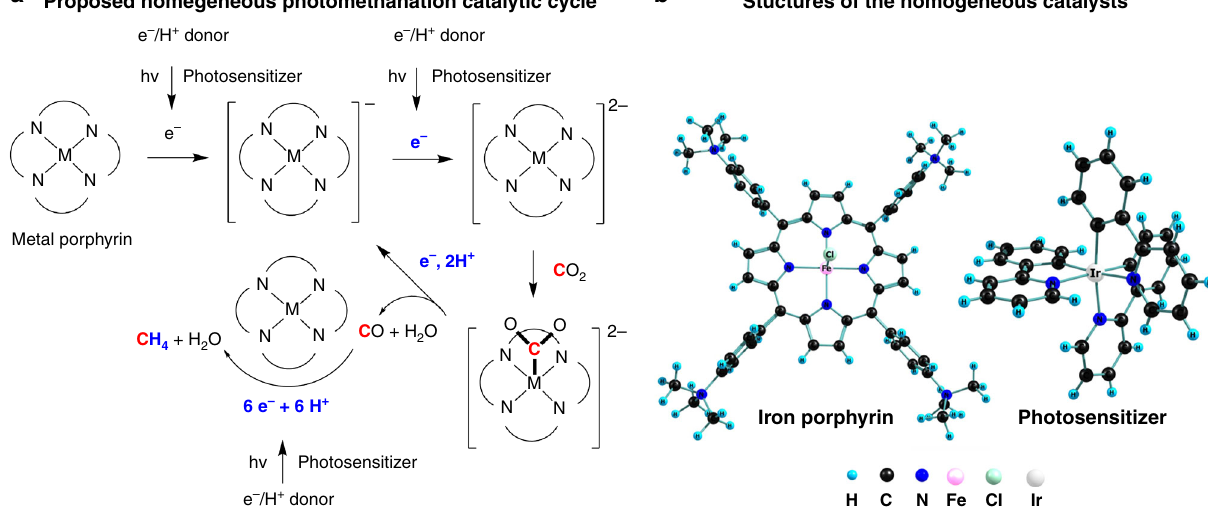
Fig. 7 a A proposed sequence of steps in the photomethanation of CO 2 , as catalyzed by a metal porphyrin in solution. b Models of the catalysts and photosensitizers (some hydrogen atoms and counterions have been omitted for clarity). Adapted with permission from Nature Publishing Group: Nature 548 , 74 – 77, Visible-light-driven methane formation from CO 2 with a molecular iron catalyst. Rao, H., Schmidt, L. C., Bonin, J. & Robert, M. (2017)